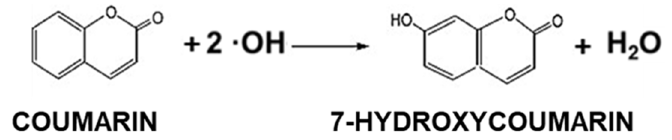
Figure 9. Hydroxyl radical reaction with coumarin resulted 7-hydroxycoumarin.